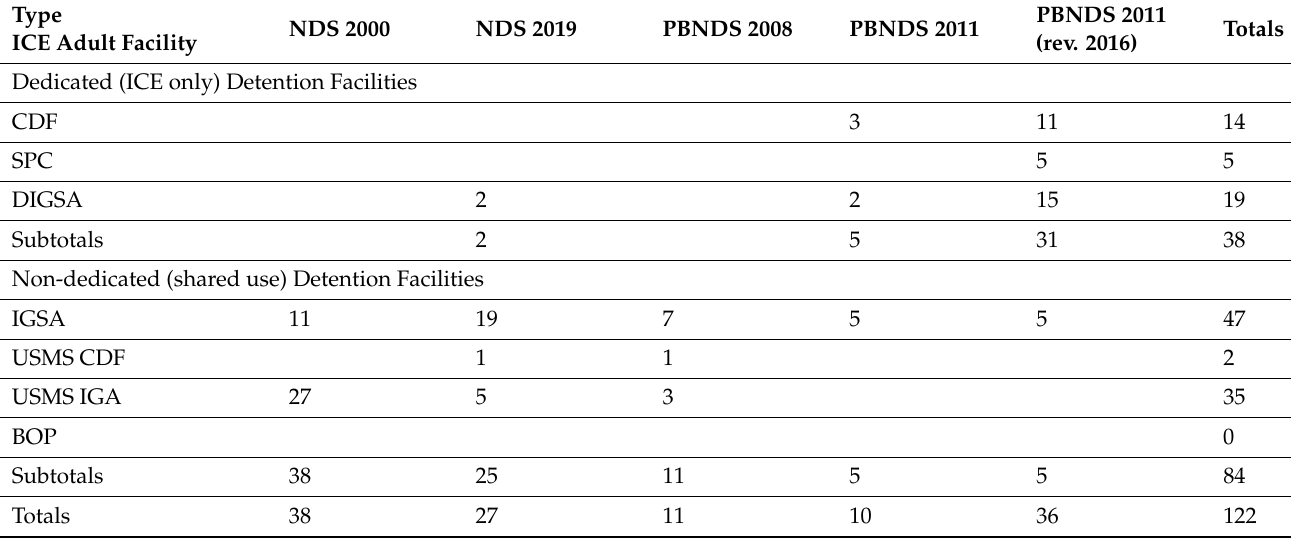
Table 2. Adult Detention Facilities by Type and Assigned Detention Standards (ICE